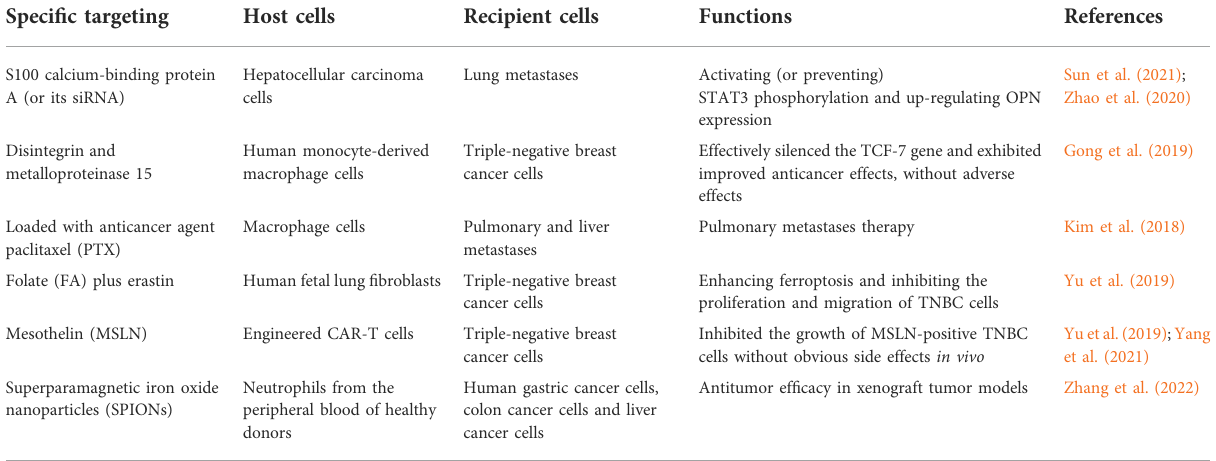
TABLE 1 Engineered exosomes in the treatment of TNBC and other